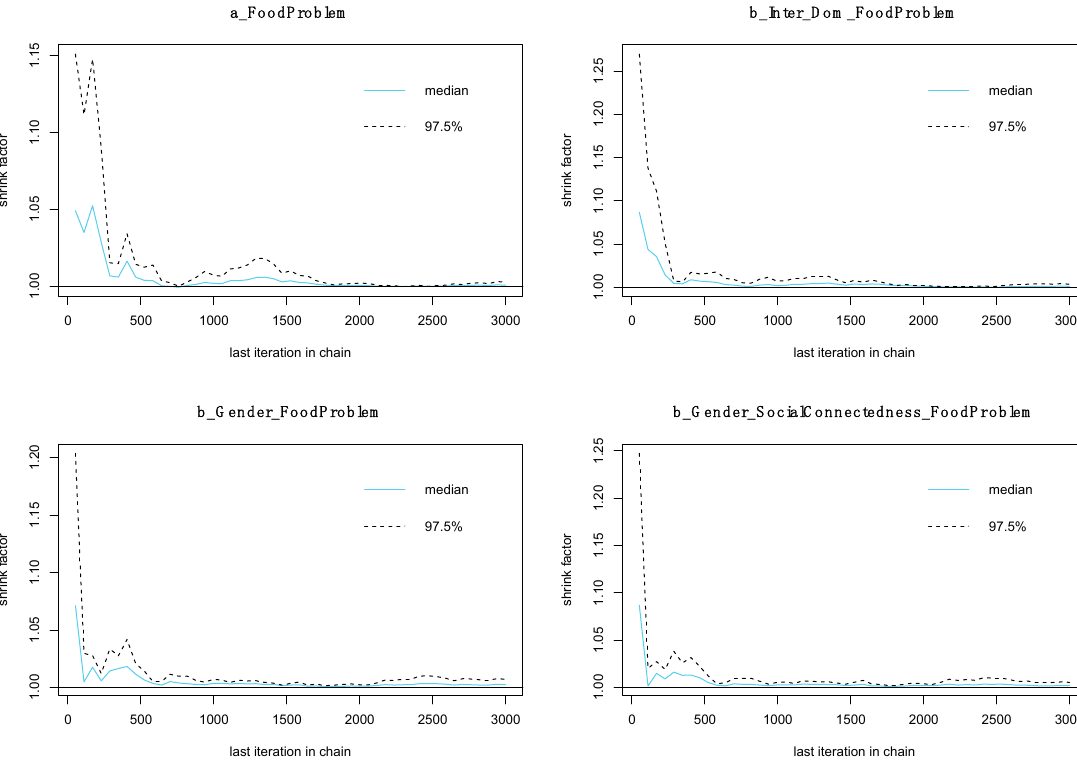
Figure 4. Gelman plots for the model’s posterior coefficients.